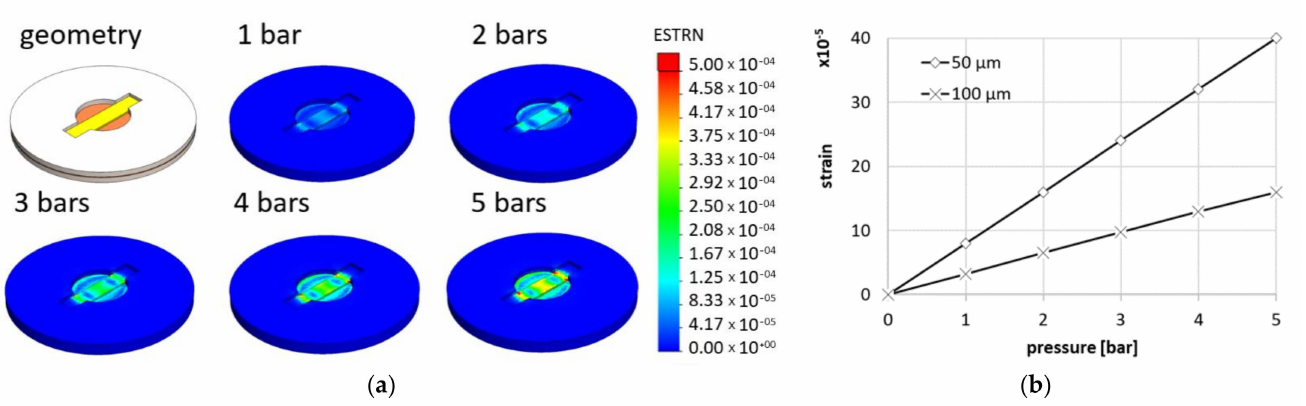
Figure 13. The strain of the piezoresistive element calculated for various pressures and thicknesses of the membrane –strain distribution for various pressures ( a ) and maximum strain as a function of pressure ( b ).